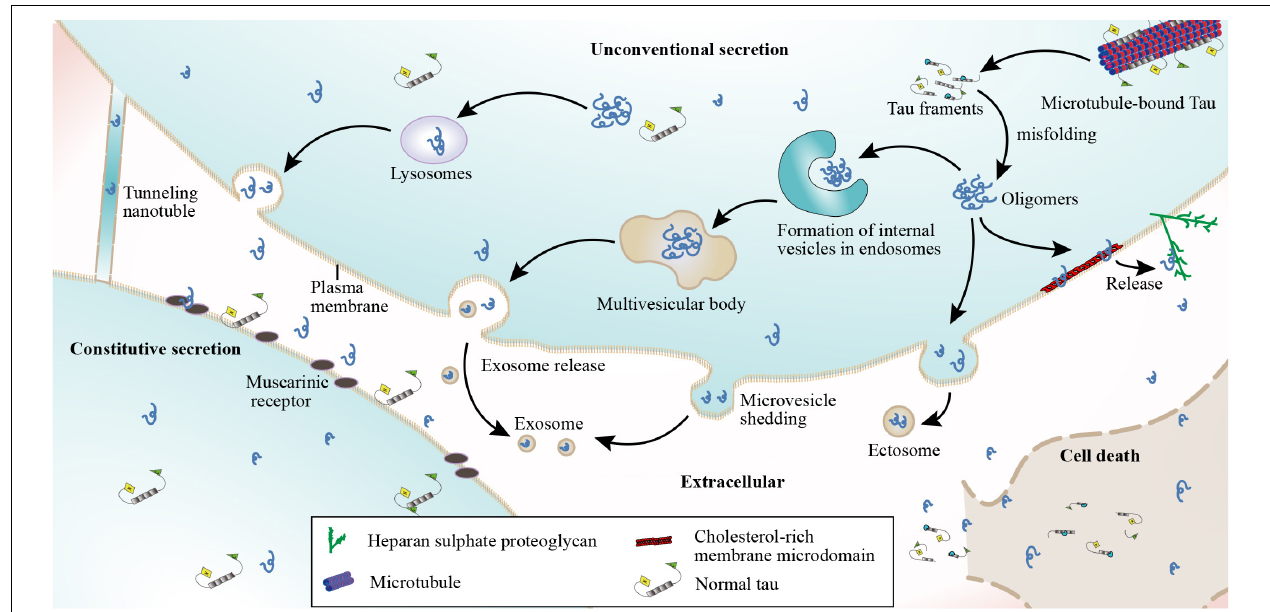
FIGURE 3 | Tau protein secretion and release. The possible mechanisms underlying the presence of tau in the extracellular space include cell death, neuroactive stimulation, constitutive secretion, and unconventional secretion. A small amount of tau can be released into the extracellular space in free form or by penetrating adjacent membranes, which can be achieved by stimulating neuroactivity or constitutive secretion. However, the methods involved in unconventional tau protein secretion include (1) non-vesicular direct translocation across the plasma membrane from the cytoplasm and extracellular trapping via HSPGs, (2) release via secretory lysosomes that fuse with the plasma membrane and release their contents into the extracellular space, (3) microvesicle shedding from the plasma membrane, and (4) vesicle-mediated exosome release. Tau can also be secreted by both neuronal and non-neuronal cells when tau protein is exogenously expressed, while extracellular tau can bind muscarinic (M1, M3) receptors. Tau may also be released through nanotubes that connect the cytoplasmic compartments of adjoining